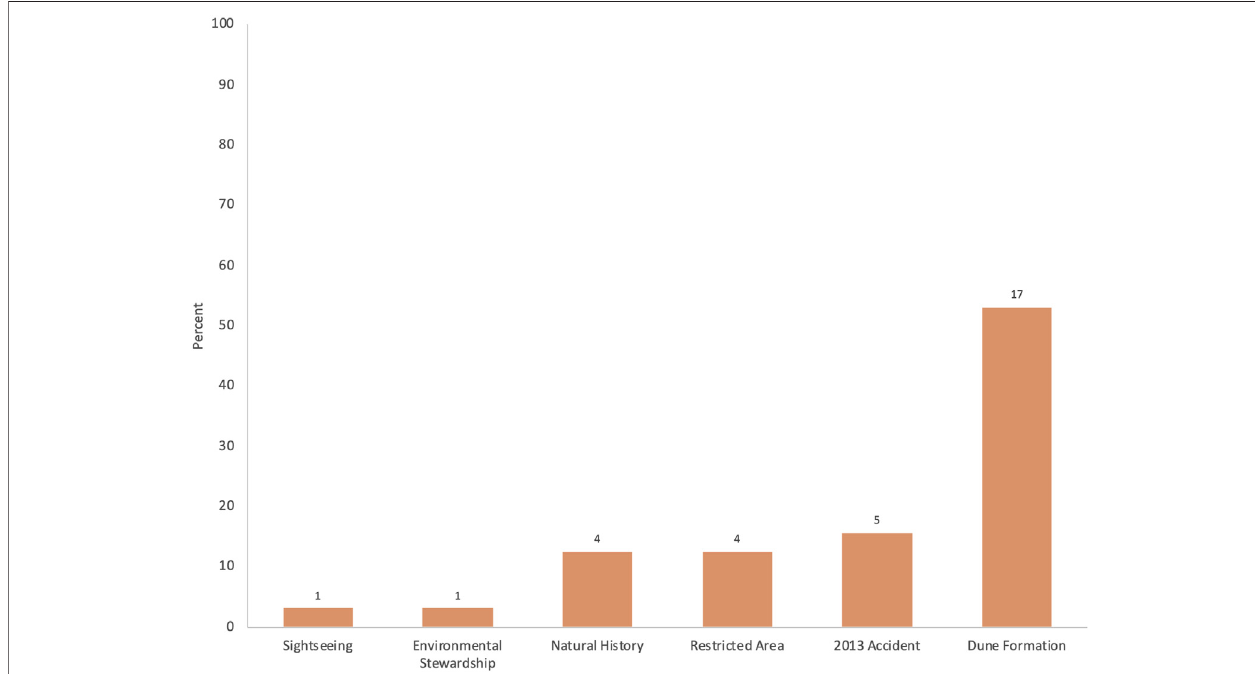
FIGURE 1 | Visitor knowledge prior to Mount Baldy hike ( n (cid:1) 34).